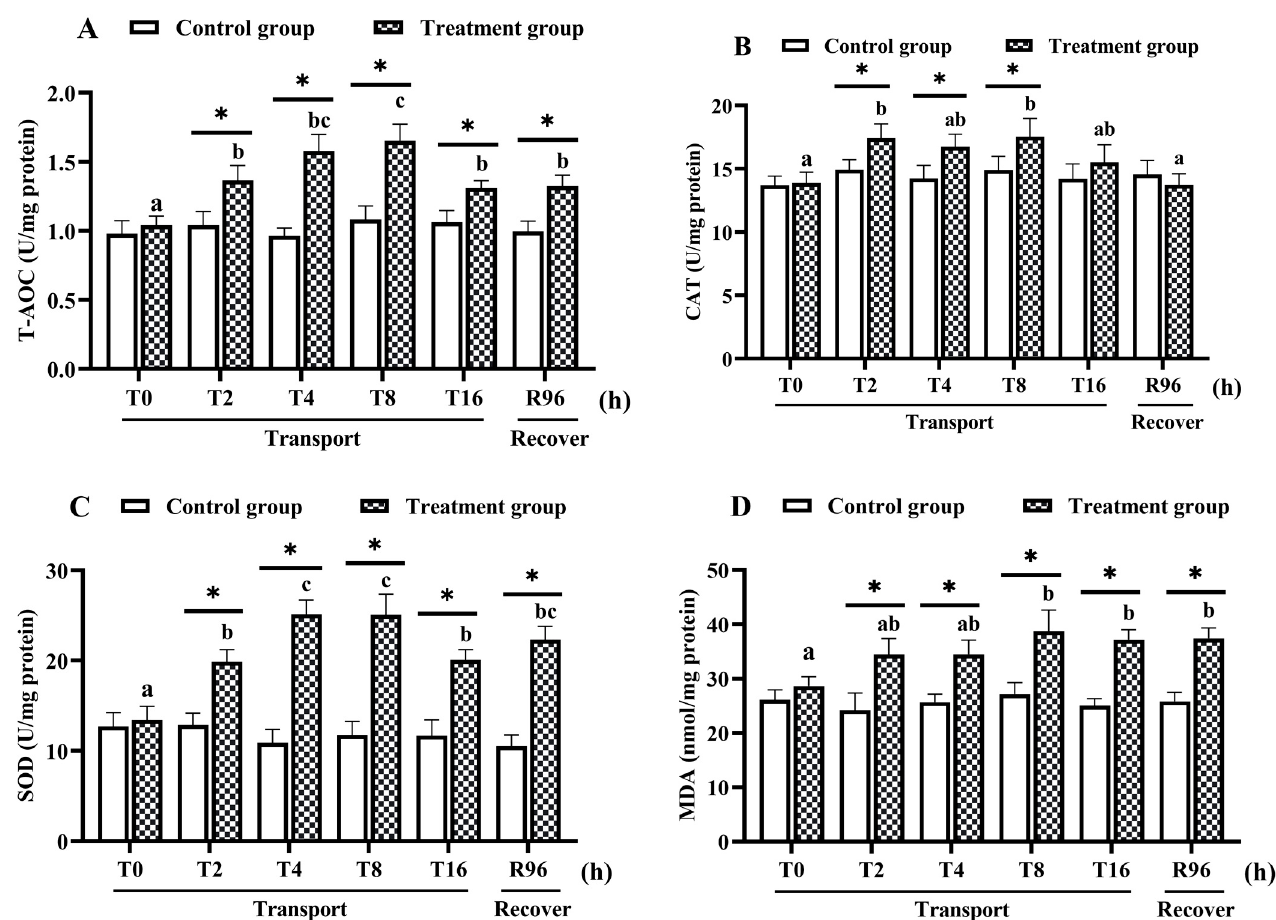
Figure 1. Intestinal antioxidant-related biochemical indices of hybrid yellow catfish under transport stress ( n = 9 replicates). ( A ) Total antioxidant capacity, T-AOC; ( B ) catalase, CAT; ( C ) superoxide dismutase, SOD; ( D ) malondialdehyde, MDA. X -axis indicates the treat time. The values were expressed as mean ± SEM. Asterisks (*) mean statistical significance ( p < 0.05) between control groups and transportation groups. Different letters indicate statistical significance ( p < 0.05) among different transport groups.